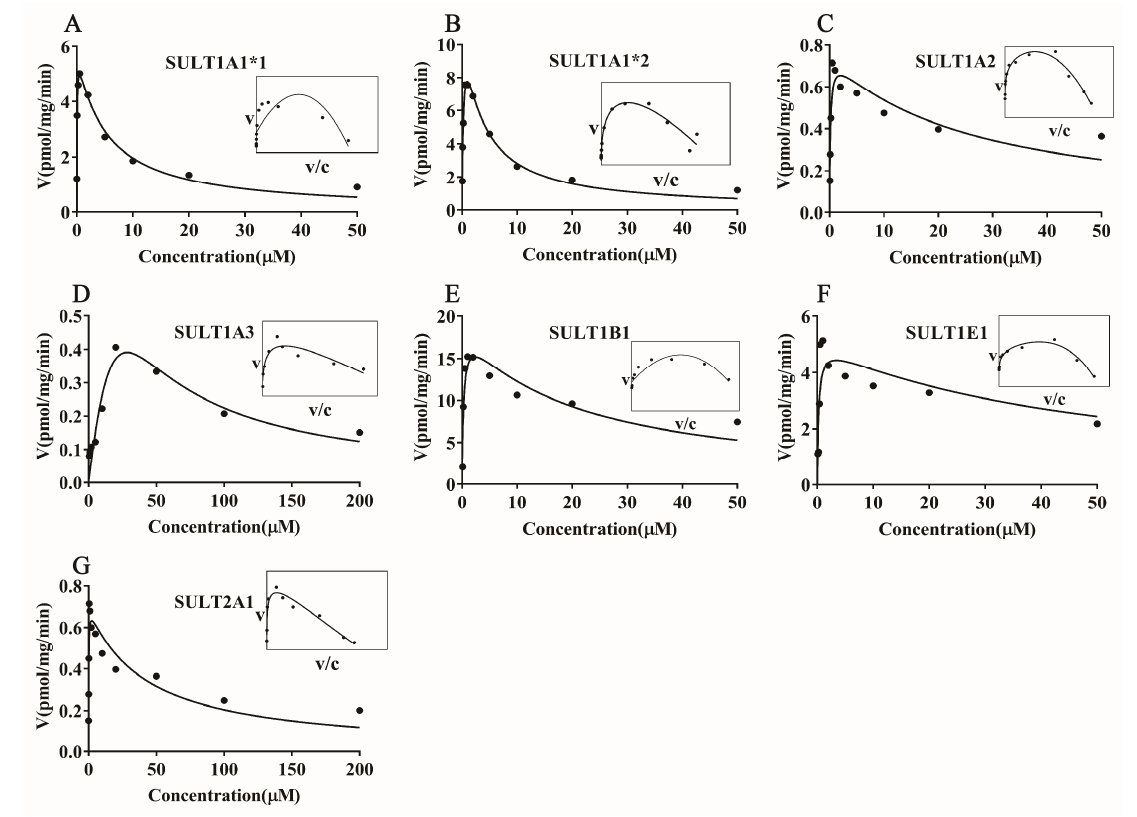
Figure 4. Identification of the major SULT enzymes responsible for the sulfation of magnolol. Formation rate of magnolol sulfated metabolite in the incubation of magnolol (25 µM) with seven recombinant human SULT isoforms (0.05 mg protein/mL). It was calculated and expressed as a nanomole per minute per milligram of protein for sulfation rates. *** p < 0.001 vs other group. Each point is the average of three determinations, and the error bar is the standard deviation of the mean.